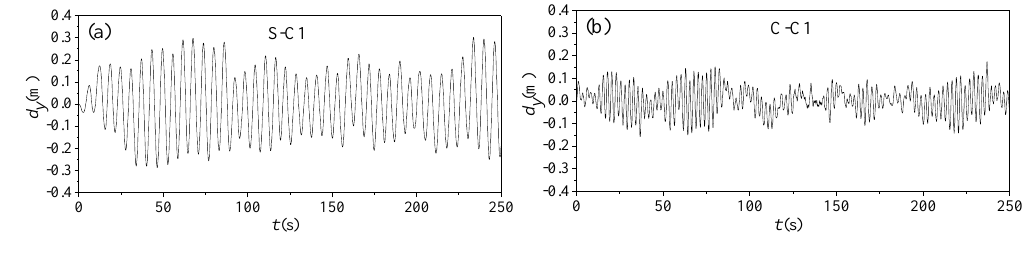
Figure 15. Wind fluctuating vibration responses of stay cables: ( a ) steel cable C1; ( b ) CFRP cable C1; ( c ) steel cable C2; ( d ) CFRP cable C2; ( e ) steel cable C3; ( f ) CFRP cable